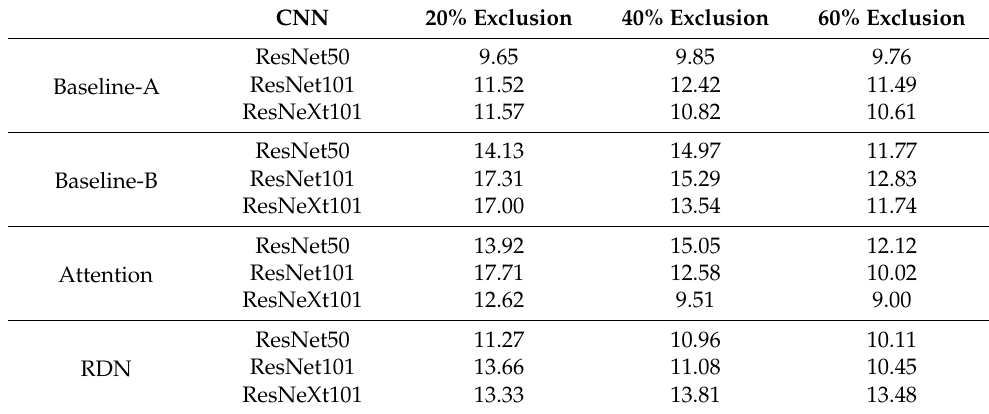
Figure 7. Illustration of partial-pixel-loss attack. ( a ) Original image, ( b ) amplitude part of encrypted image, ( c ) encrypted image with 20% excluded pixels, ( d ) encrypted image with 40% excluded pixels, and ( e ) encrypted image with 60% excluded pixels. Table 7. CIDEr-score performance based on partial-pixel-loss attack.